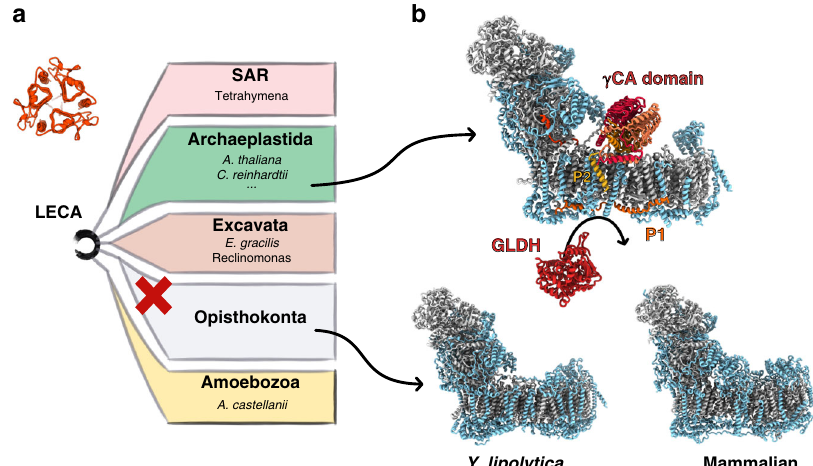
Fig. 4 Plant mitochondrial complex I speci fi c subunits. a Schematic representation of the fi ve major eukaryote lineages. Organisms where γ -carbonic anhydrase is proposed to be part of mitochondrial complex I are listed next to their respective lineage. The red cross indicate the loss of mitochondrial γ - carbonic anhydrase in opisthokonta. b Comparison of mitochondrial complex I structures. Core subunits are shown in light gray and supernumary subunits in light blue. Plant speci fi c proteins are highlighted in red-orange colors. Y. lipolytica (PDB:6RFR) and mammalian (PDB:6G2J) complex I do not have the γ - carbonic anhydrase eukaryotic lineages except opisthokonts — we present for the fi rst time the structure of a mitochondrial complex I featuring this ancestral component. Moreover, we describe a yet unobserved plant-speci fi c assembly intermediate, shedding light into the respiratory complex I maturation.